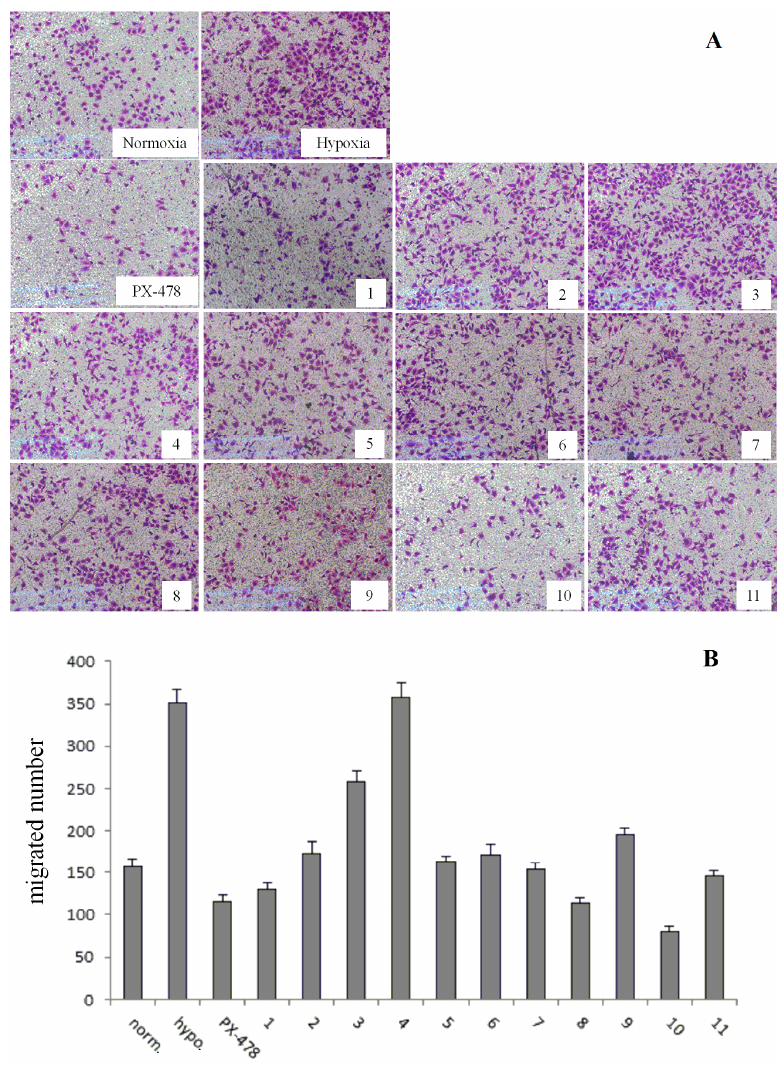
Figure 1. Preliminary screening of the effects on migration of SMMC7721 cells under hypoxia conditions of compounds 1 – 11 (20 µ M) compared with positive control (PX-478, 25 µ M) by transwell assays. Hypoxia culture condition was established by 150 µ M CoCl 2 induction for 24 h. 1 × 10 5 cells were seeded into the transwell migration chamber and exposed to compounds for 24 h. (A) The migrated cells at the lower side of the membrane were then stained using Crystal Violet. (B) The quantification analysis. Column, mean; bar, standard deviation; n = 3.